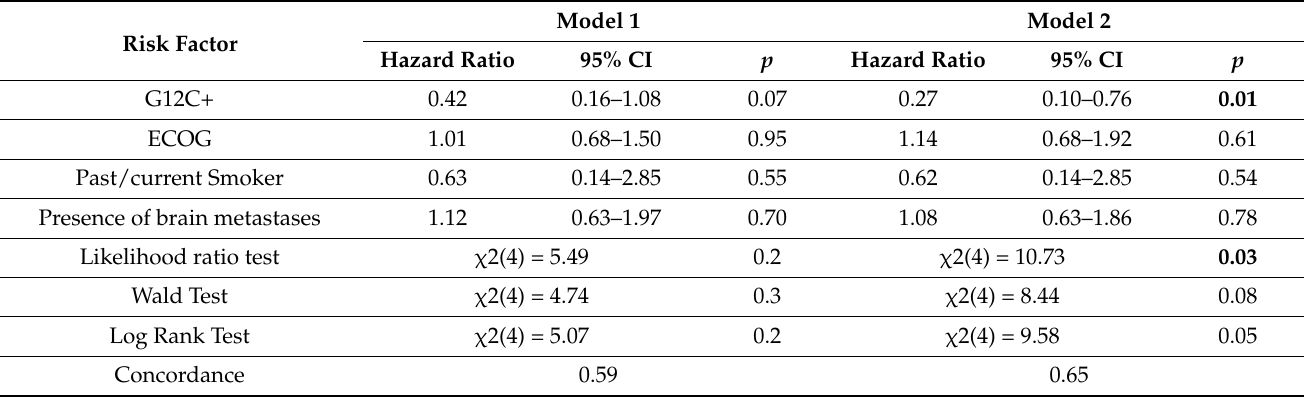
Table 3. Description of Cox Proportional Hazard Models (PFS) for G12C+/ − . Abbreviations: CI, confidence interval; G12C+, patients with G12C mutation in KRAS gene; p , p value. Statistically significant p values are shown in